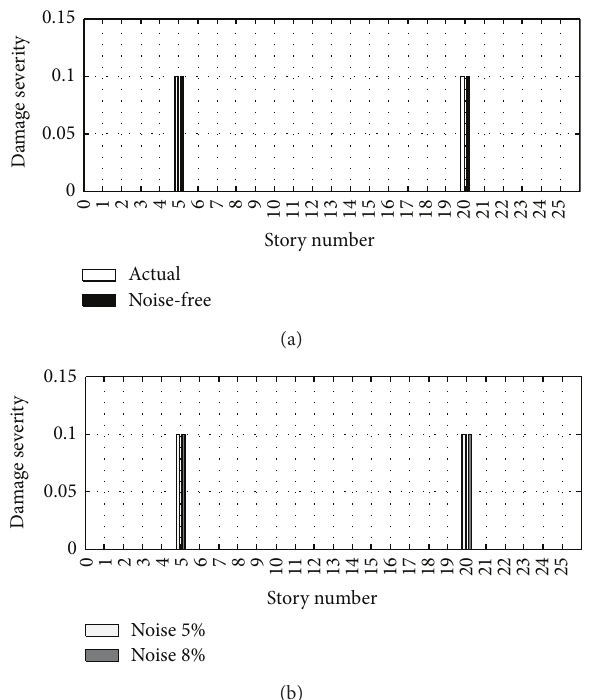
Figure 15: Damage detection results in the 25-story shear frame for scenario II.